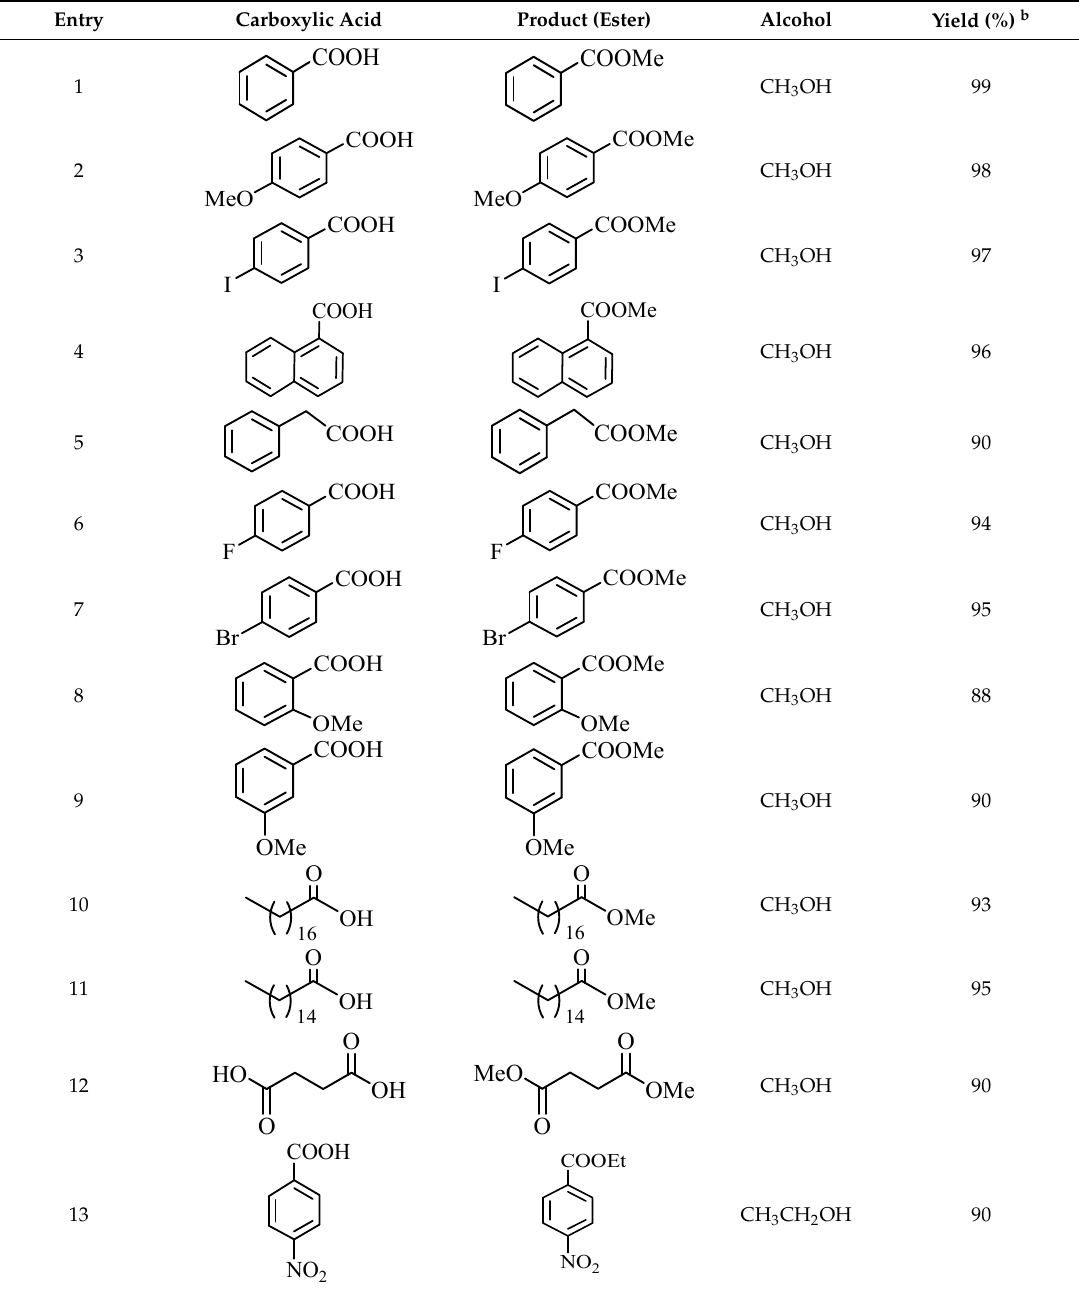
Table 2. Esterification of carboxylic acid derivatives using supported iron oxide nanoparticles a .